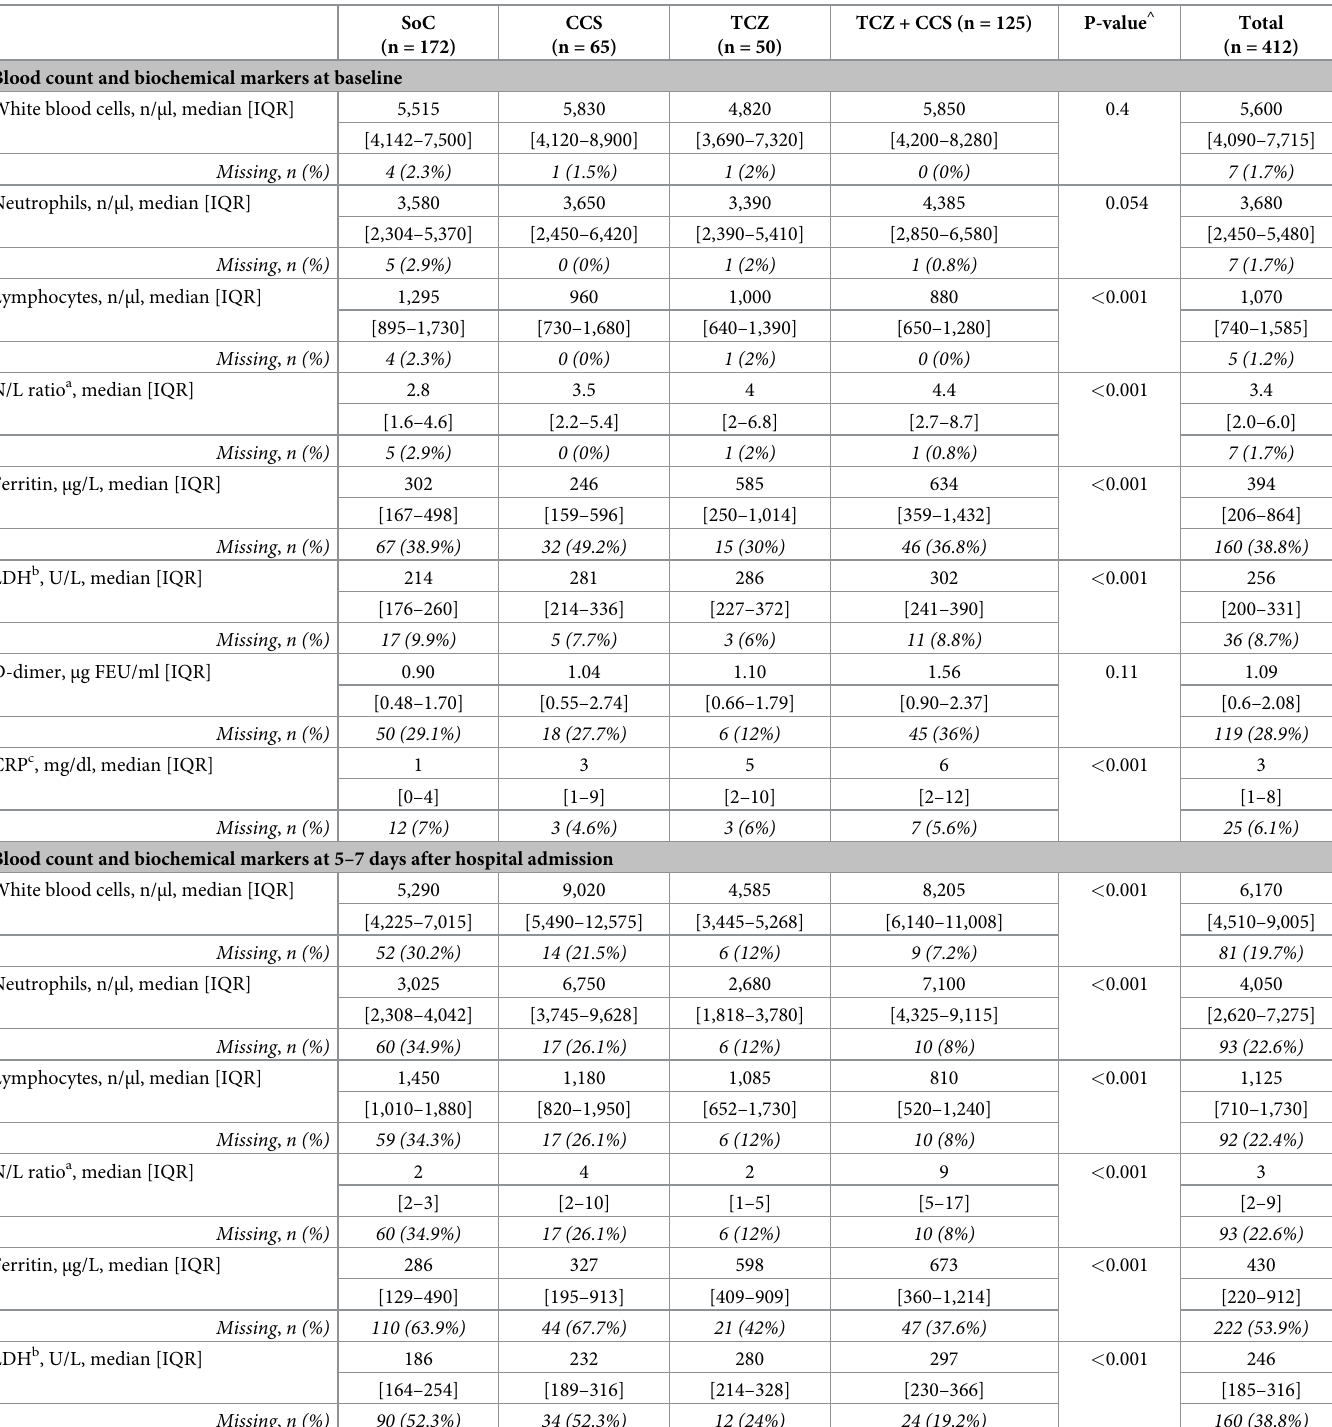
Table 2. Blood count and biochemical markers at baseline and 5–7 days after hospital admission by treatment’ group.